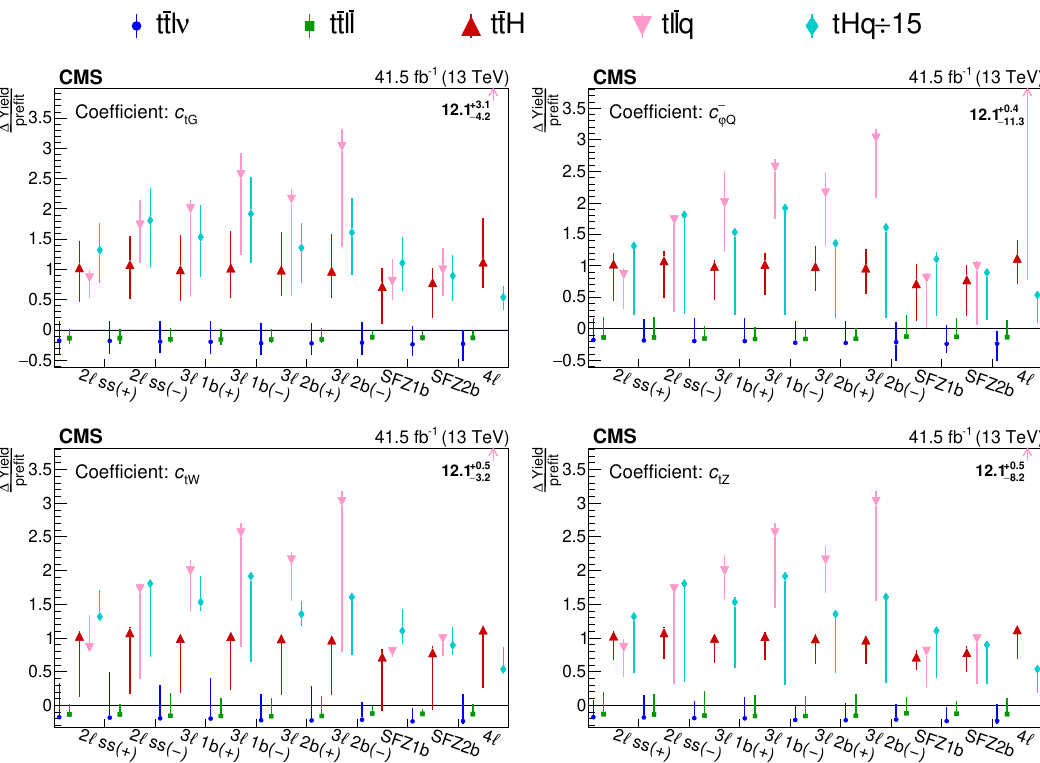
Figure 11 . Plots showing the relative change in the expected yield for the signal processes in each event category. The “ ∆ Yield/prefit” is the difference in expected yield before fit (prefit) and after fit (postfit), normalized to the prefit yield of the process in the corresponding category. The vertical bars represent the maximum variation for a given WC within the corresponding 2 σ confidence interval. The values in upper right of each plot are to indicate the variation for tllq in the 4 ‘